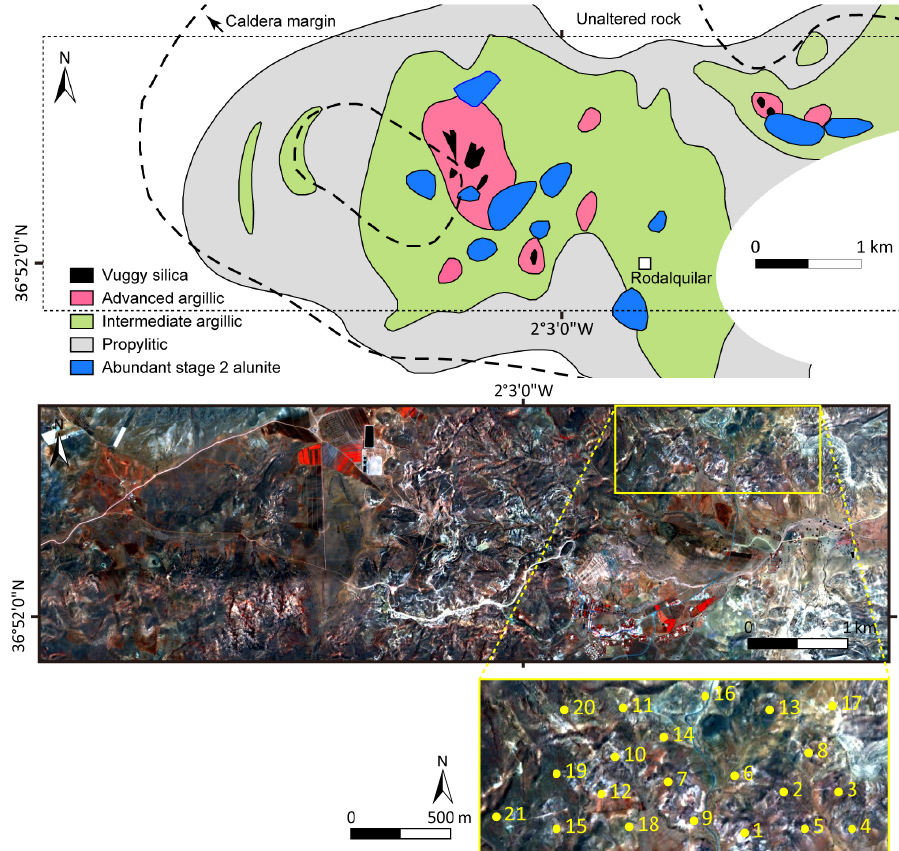
Figure 1. Top : Schematic surface alteration map of the study area (modified from [38]). The dotted rectangle indicates the approximate outline of the study area; Bottom : The scene is displayed in false color composite (R: 750 nm, G: 550 nm, B: 450 nm) made from the original HyMap image. Bright red represents cultivated cropland, and shades of red show distribution of various vegetated land covers. Numbered points in the enlarged image are 21 locations for validation of spectral signatures [37].